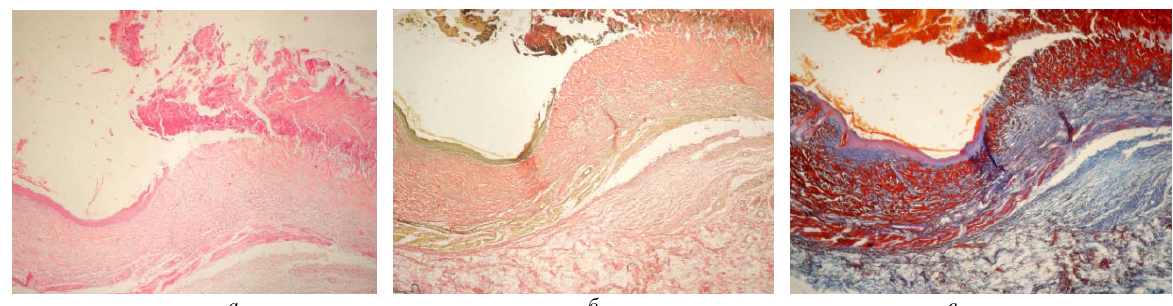
Рис . 3. Дослідна група тварин , яких лікували метилурациловою маззю : зона термічного пошкодження покрита струпом , під яким розташовується тонкий шар фібриноїдного некрозу , нижче – тонкий пласт грануляційної тканини і шар